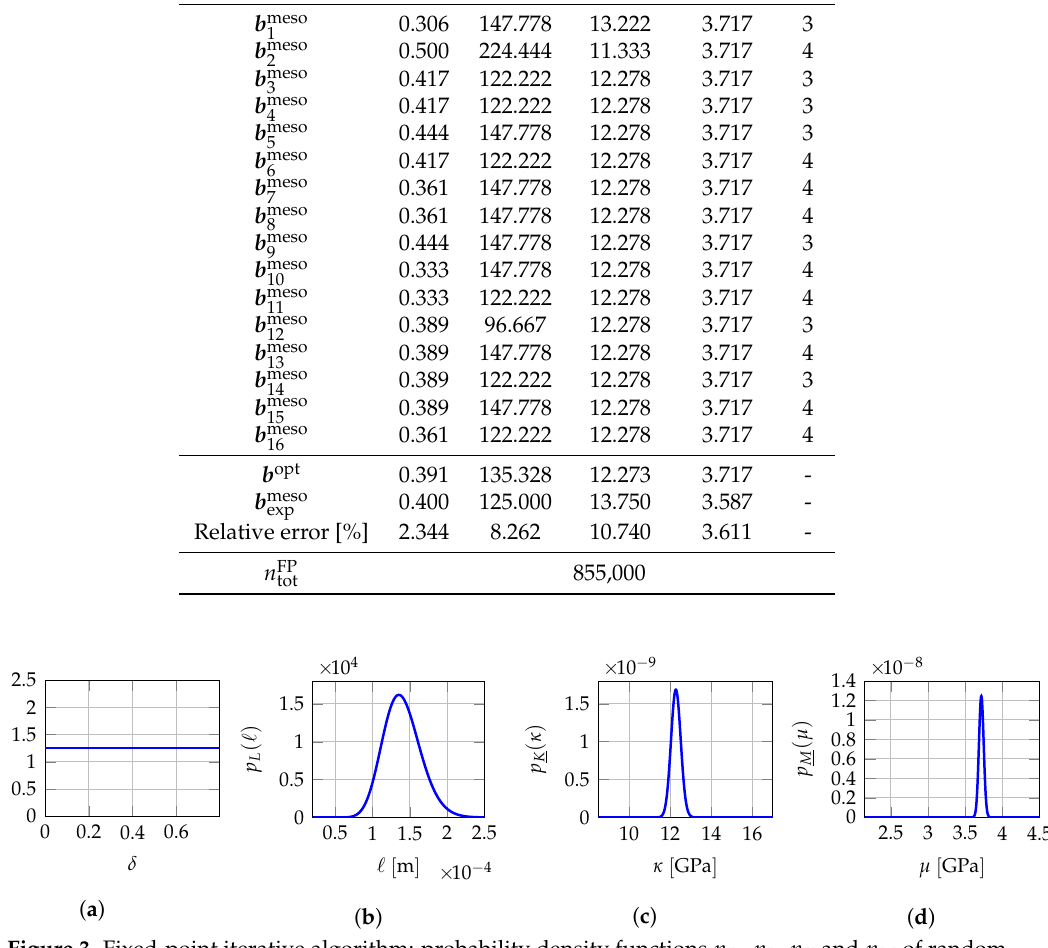
Figure 3. Fixed-point iterative algorithm: probability density functions p D , p L , p K and p M of random variables D , L , K and M , respectively. ( a ) p D ( δ ) ; ( b ) p L ( (cid:96) ) ; ( c ) p K ( κ ) ; ( d ) p M ( µ )